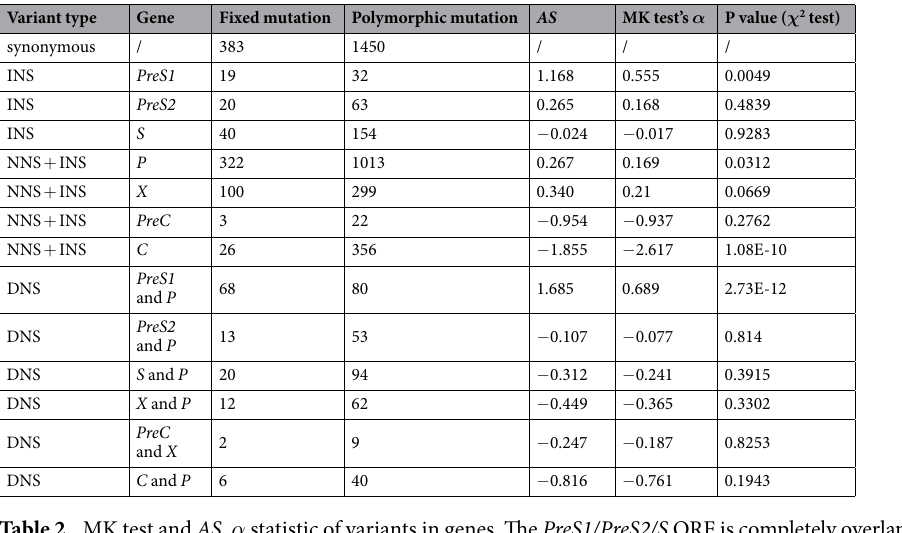
Table 2. MK test and AS , α statistic of variants in genes. The PreS1/PreS2/S ORF is completely overlapped by P ORF, therefore PreS1, PreS2, S contains no NNS